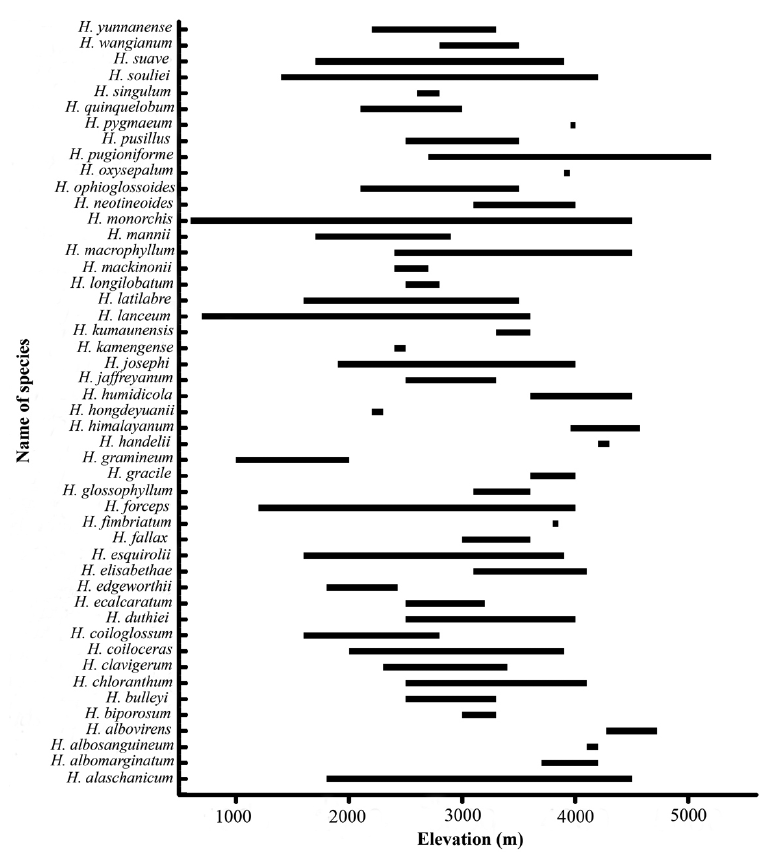
Figure 3. Elevational range of Herminium